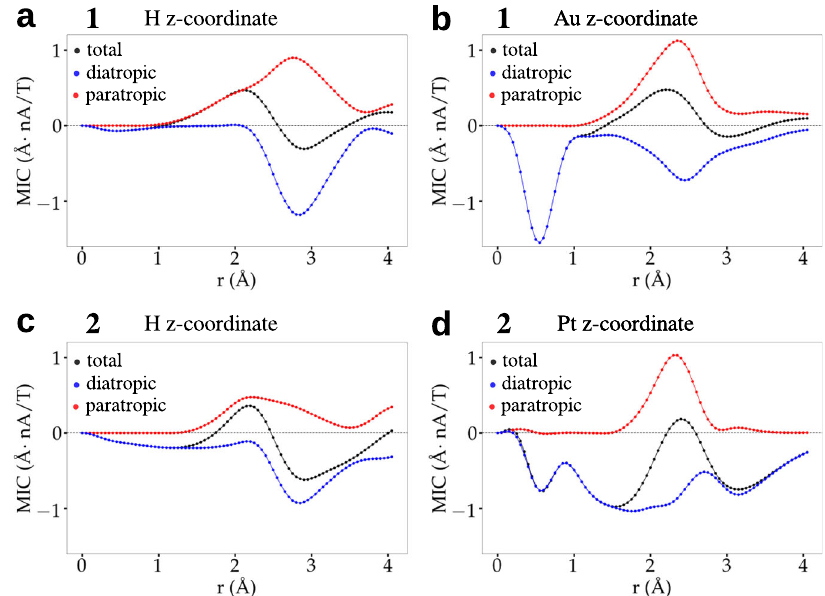
Fig. 3 Integrated currents. Circularly integrated current pro fi le of the signed modulus of J(r) for ( a , b ) [HAu 9 (PPh 3 ) 8 ] 2 + (cluster 1, top row) and ( c , d ) [HPtAu 8 (PPh 3 ) 8 ] + (cluster 2, bottom row). The integrals are done in the x-y planes shown in Fig. 2, having either core-hydrogen or Au/Pt at the origin. Diatropic (blue), paratropic (red), and total (black) contributions are